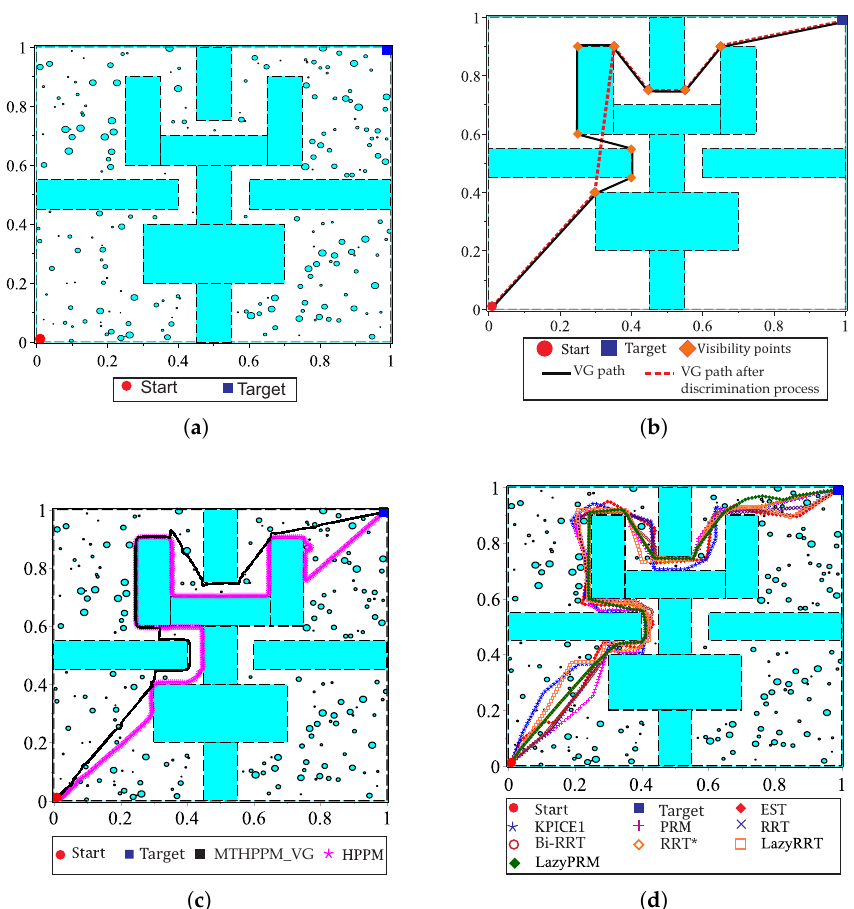
Figure 21. Comparative results for case study 3; best run of each SBP algorithm. ( a ) Path planning problem case study 3. ( b ) Visibility graph path without circular obstacles. ( c ) Paths obtained with HPPM and MTHPPM_VG. ( d ) Paths obtained with SBP